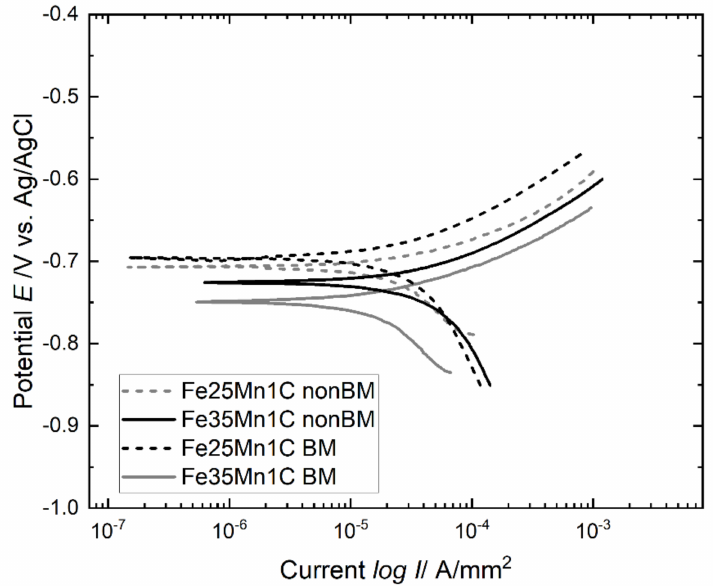
Figure 5. Representative potentiodynamic polarization curves of FeMnC samples. Table 3. Electrochemical properties of FeMnC samples. Values in parentheses show standard deviation.